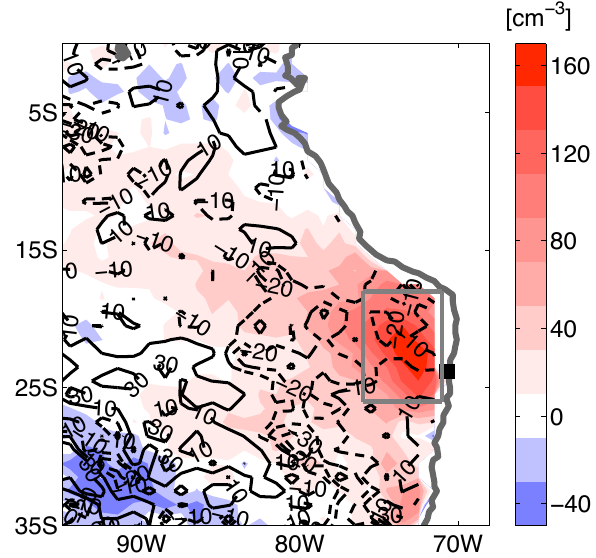
Fig. 2. As Fig. 2 but for the MAX-MIN N d composite differences: Figure 2. As Fig. 2 but for the MAX-MIN N d composite differences: N d (colors) and N d (colors) and LWP LWP (contours).